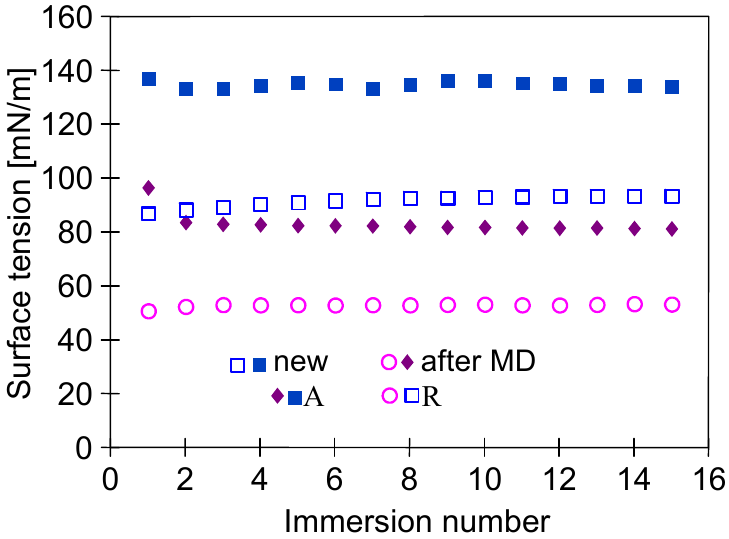
Figure 10. Changes in advancing (A) and receding (R) angles measured by the Wilhelmy plate method. Samples: new—virgin membrane; after MD—membrane collected from module M#1 after 2000 h of MD process.